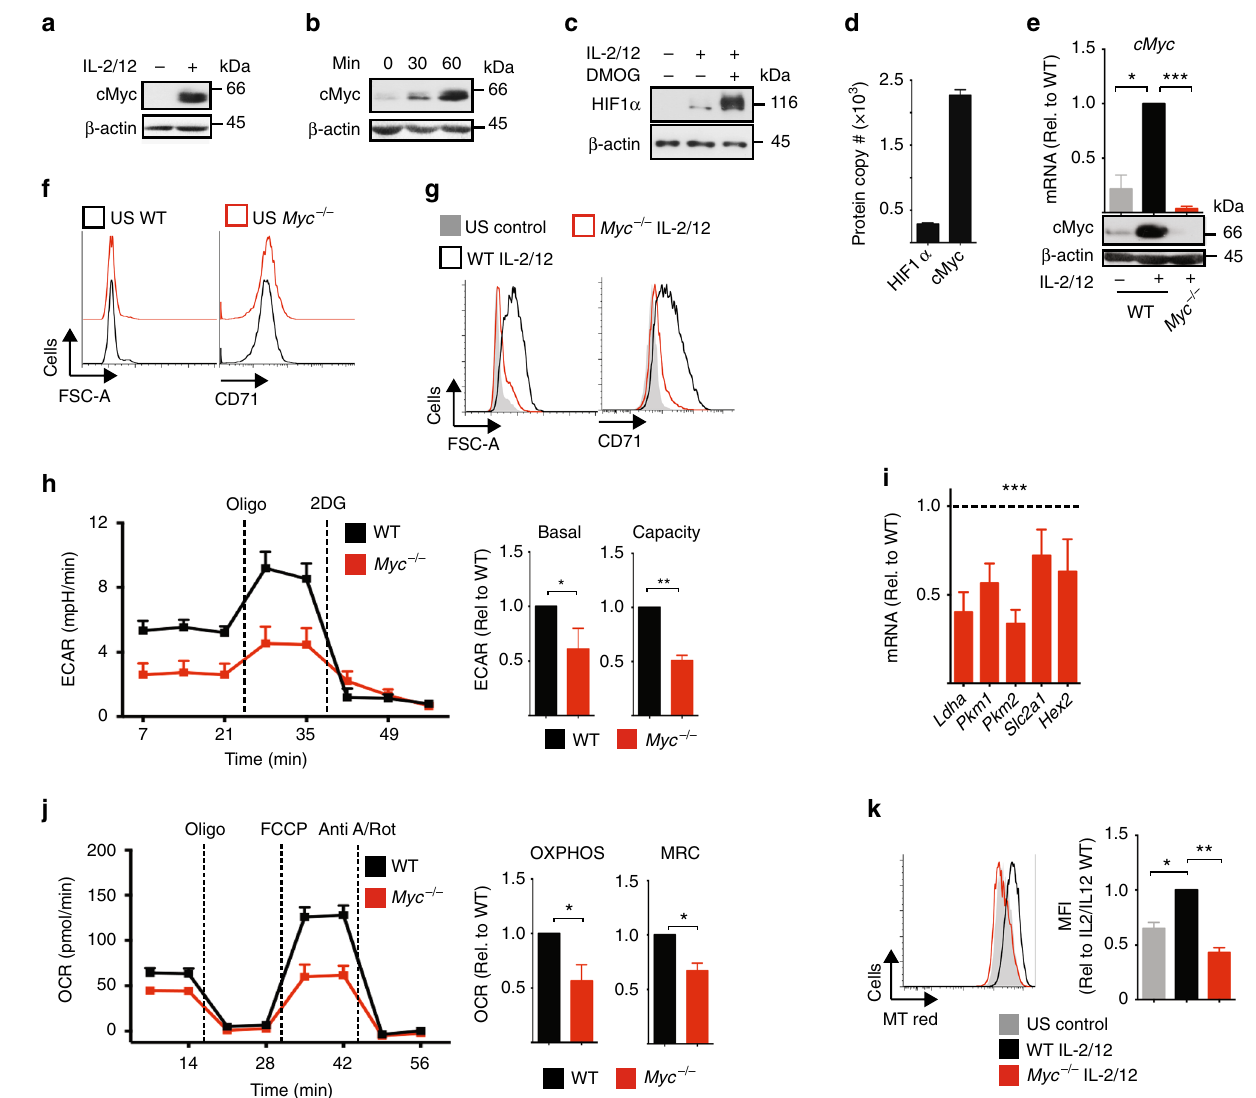
Fig. 1 cMyc is required for IL-2/IL-12-induced NK cell metabolism. a – c NK cells were left unstimulated (US) or were stimulated with IL-2/IL-12 for 18 h ( a , c ) or for the time points indicated ( b ). DMOG (200 μ M) was added for the last 2 h of activation as indicated ( c ). Samples were analysed by immunoblot for cMyc, HIF1 α and β -actin protein expression. d NK cells were stimulated with IL-2/IL-12 for 18 h and protein copy numbers of HIF1 α and cMyc per cell were determined using quantitative proteomic analysis. e – k cMyc − / − ( cMyc fl ox/ fl ox x Tamox-Cre) or WT ( cMyc WT/WT x Tamox-Cre) NK cells were left unstimulated or stimulated for 18 h with IL-2/12. e qPCR and immunoblot analysis were used to determine the expression of cMyc mRNA and cMyc protein, respectively. f , g Flow cytometry analysis of FSC-A and CD71 expression. h Analysis of NK cell extracellular acidi fi cation rate (ECAR) to assess basal glycolytic rate and glycolytic capacity. i qPCR analysis of mRNA for lactate dehydrogenase ( Ldha ), pyruvate kinases ( Pkm1 , Pkm2 ), the Glut1 glucose transporter ( Slc2a1 ) and hexokinase 2 ( Hex2 ). j Analysis of NK cell oxygen consumption rate (OCR) to assess rates of OXPHOS and maximal respiration. k Flow cytometry analysis of mitochondrial mass using MitoTracker Red (MT Red) staining. Data are mean ± s.e.m. of 3 ( d – k ) or 4 ( h , j ) experiments, or representative of 3 ( a – c , k ), 4 ( h , j ) or 6 ( f , g ) individual experiments. h , j For representative plots, the data were normalised to 200,000 cells. Statistical analysis was performed using a two-way ANOVA with Tukey post test ( e – k ) or one-sample t -test vs. a theoretical value of 1 ( h , j ); * p < 0.05, ** p <